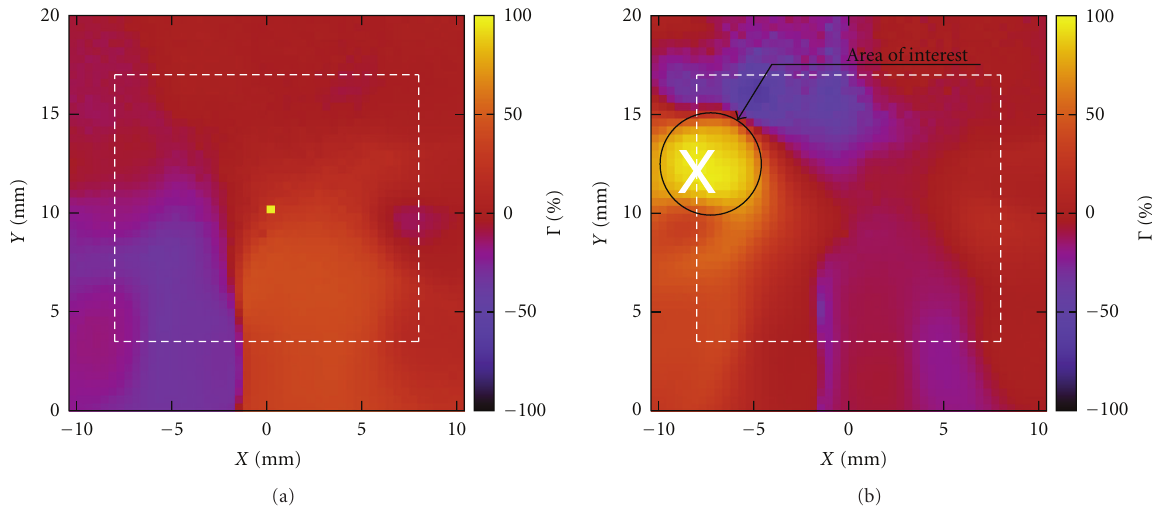
Figure 3: Normalized cross-correlation maps obtained when the reference point, marked with a white cross, is useless (a) or of interest (b).